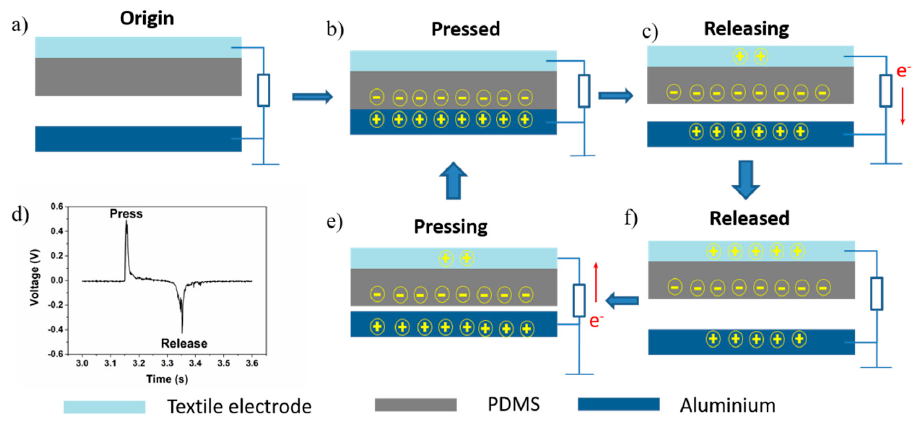
Figure 2. ( a – c , e , f ) TENG working principles; ( d ) press and release signal pulse.